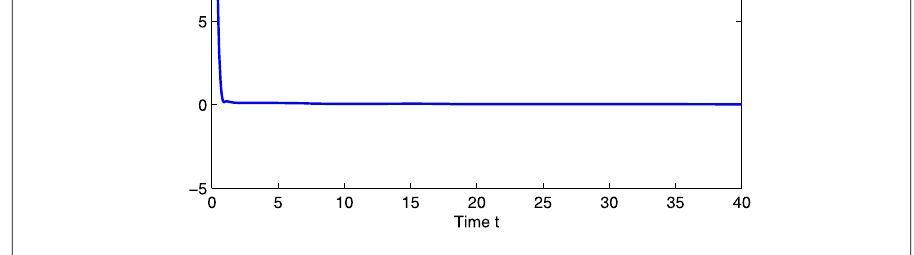
Figure 3 The trajectory of L ( t ) in Example 4.4